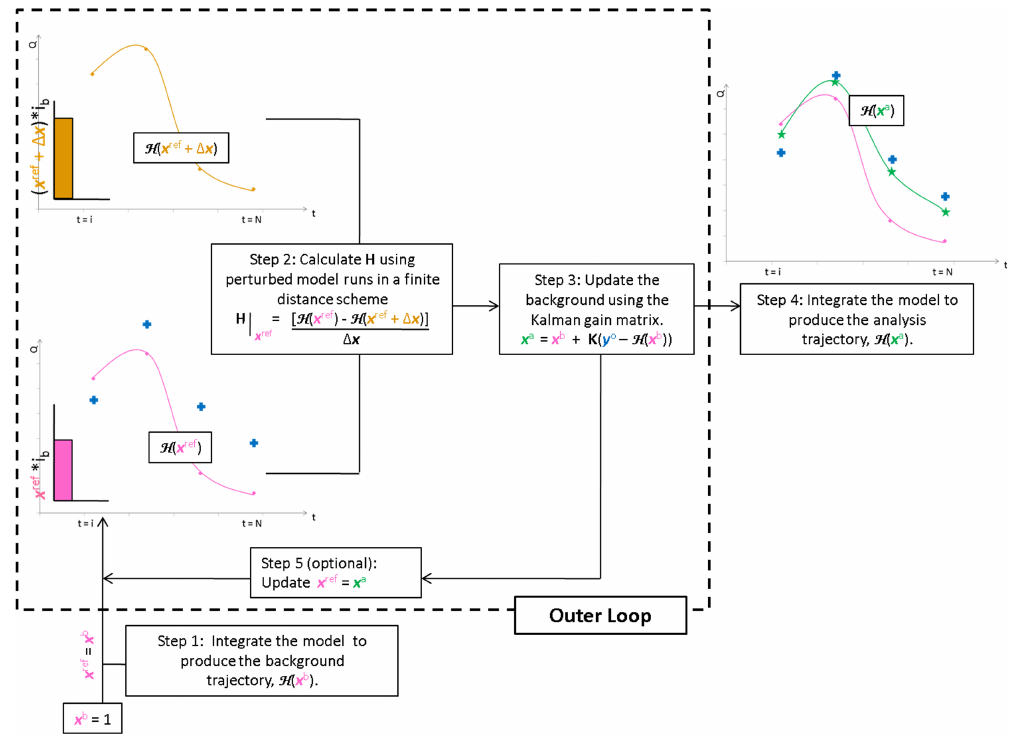
Fig. 5. Schematic representation of the EKF: the background model trajectory ( Q sim,b in pink) is corrected using observations ( Q obs , blue crosses) to produce the analysis model trajectory ( Q a in green) during steps 1 through 4. In step 5, the observation operation is re-linearised in the vicinity of the analysis and steps 2 and 3 are repeated to form an “outer